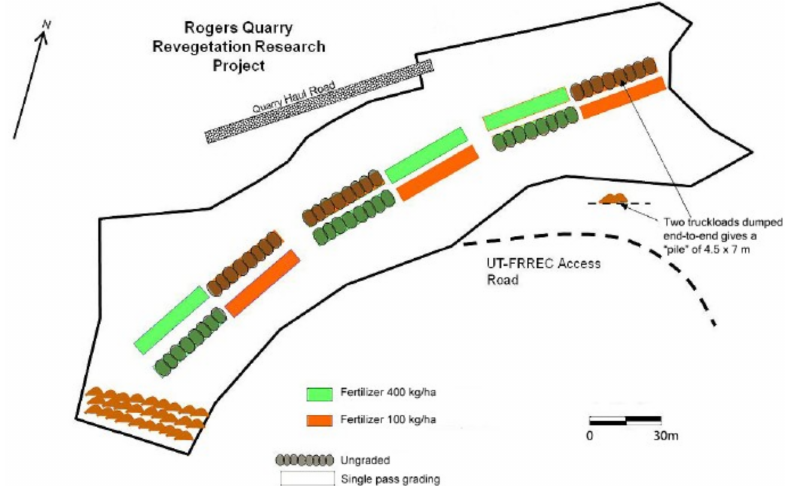
Figure 1. Arrangement of plots and treatments on a reclaimed quarry site in Oak Ridge, TN. Ungraded plots appear darker in